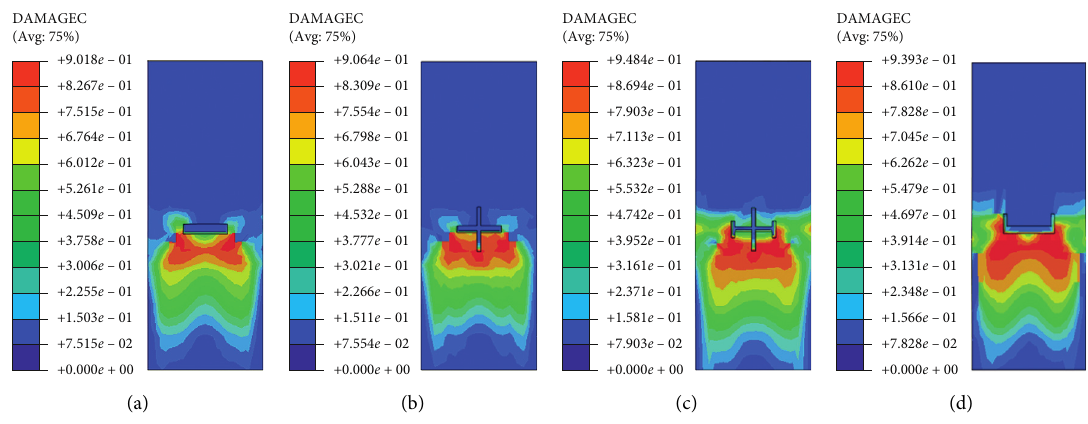
Figure 13: Damage nephogram of concrete: (a) B